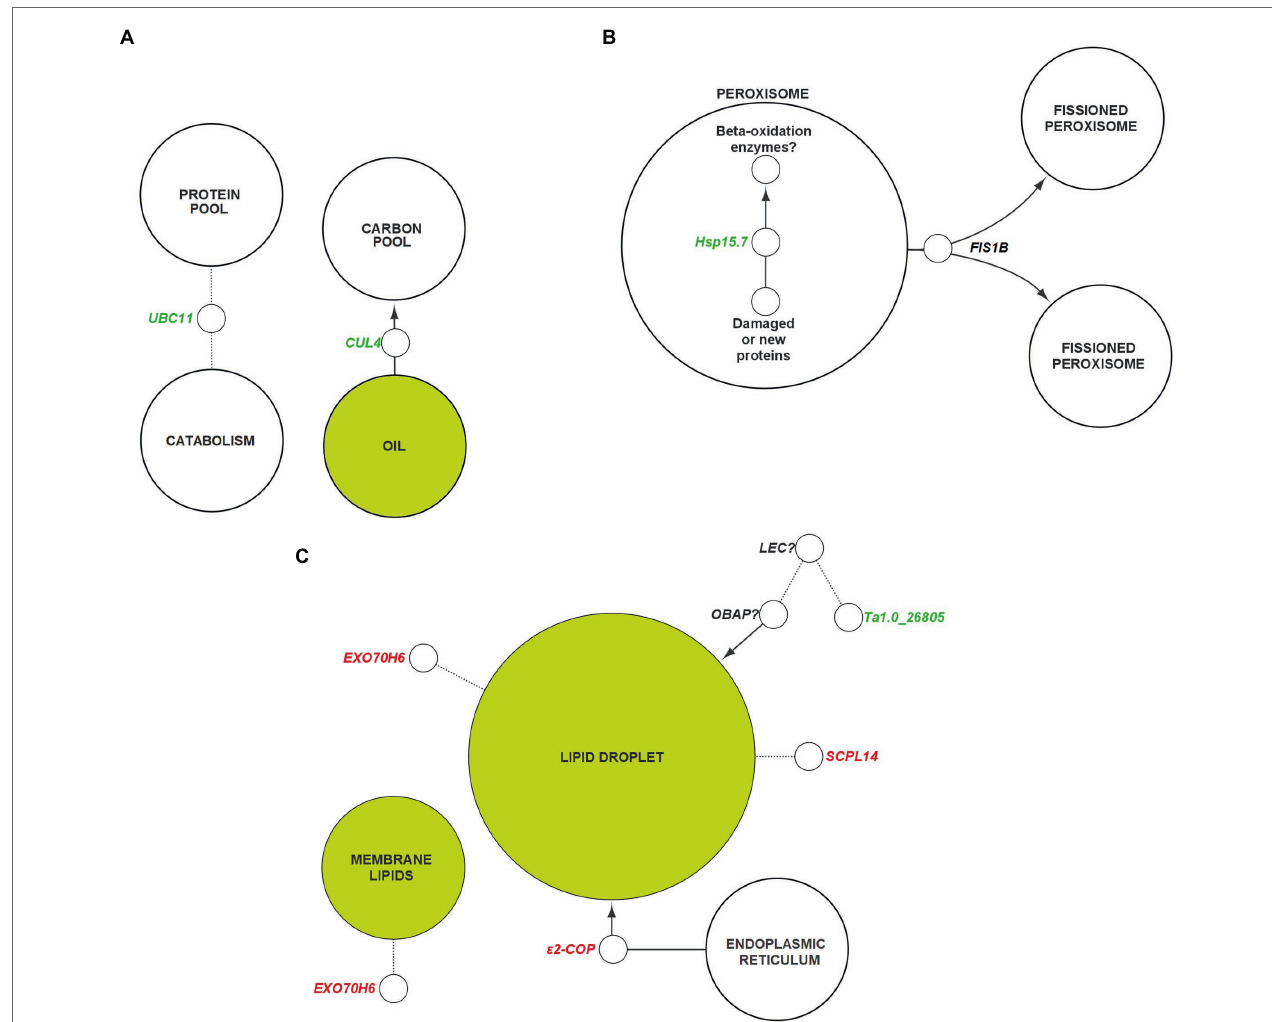
FIGURE 8 | General pathways and components of plant metabolism containing potential targets for genetic engineering. (A) Ubiquitination, (B) peroxisome, (C) membranes and lipid droplets. Genes colored in green indicate those that are suggested to be negatively correlated with oil content, whereas genes in red indicate those that are positively correlated with oil content. Dotted lines indicate unconfirmed interactions between components/genes. Arrowheads indicate a gene or component has a net positive effect on the accumulation of their target. Genes with question marks are suggested targets that require specific identification within the respective gene family in Thlaspi arvense . Yellow nodes indicate lipid-related components. Italics indicate gene transcripts or corresponding protein could be interactor indicated by node. CUL, CULLIN; ε 2-COP, epsilon2 coat protein; EXO70, exocyst subunit exo70; FIS, FISSION; Hsp, heat shock protein; LEC, leafy cotyledon; OBAP, oil body associated protein; SCPL, serine carboxypeptidase-like; UBC, ubiquitin-conjugating